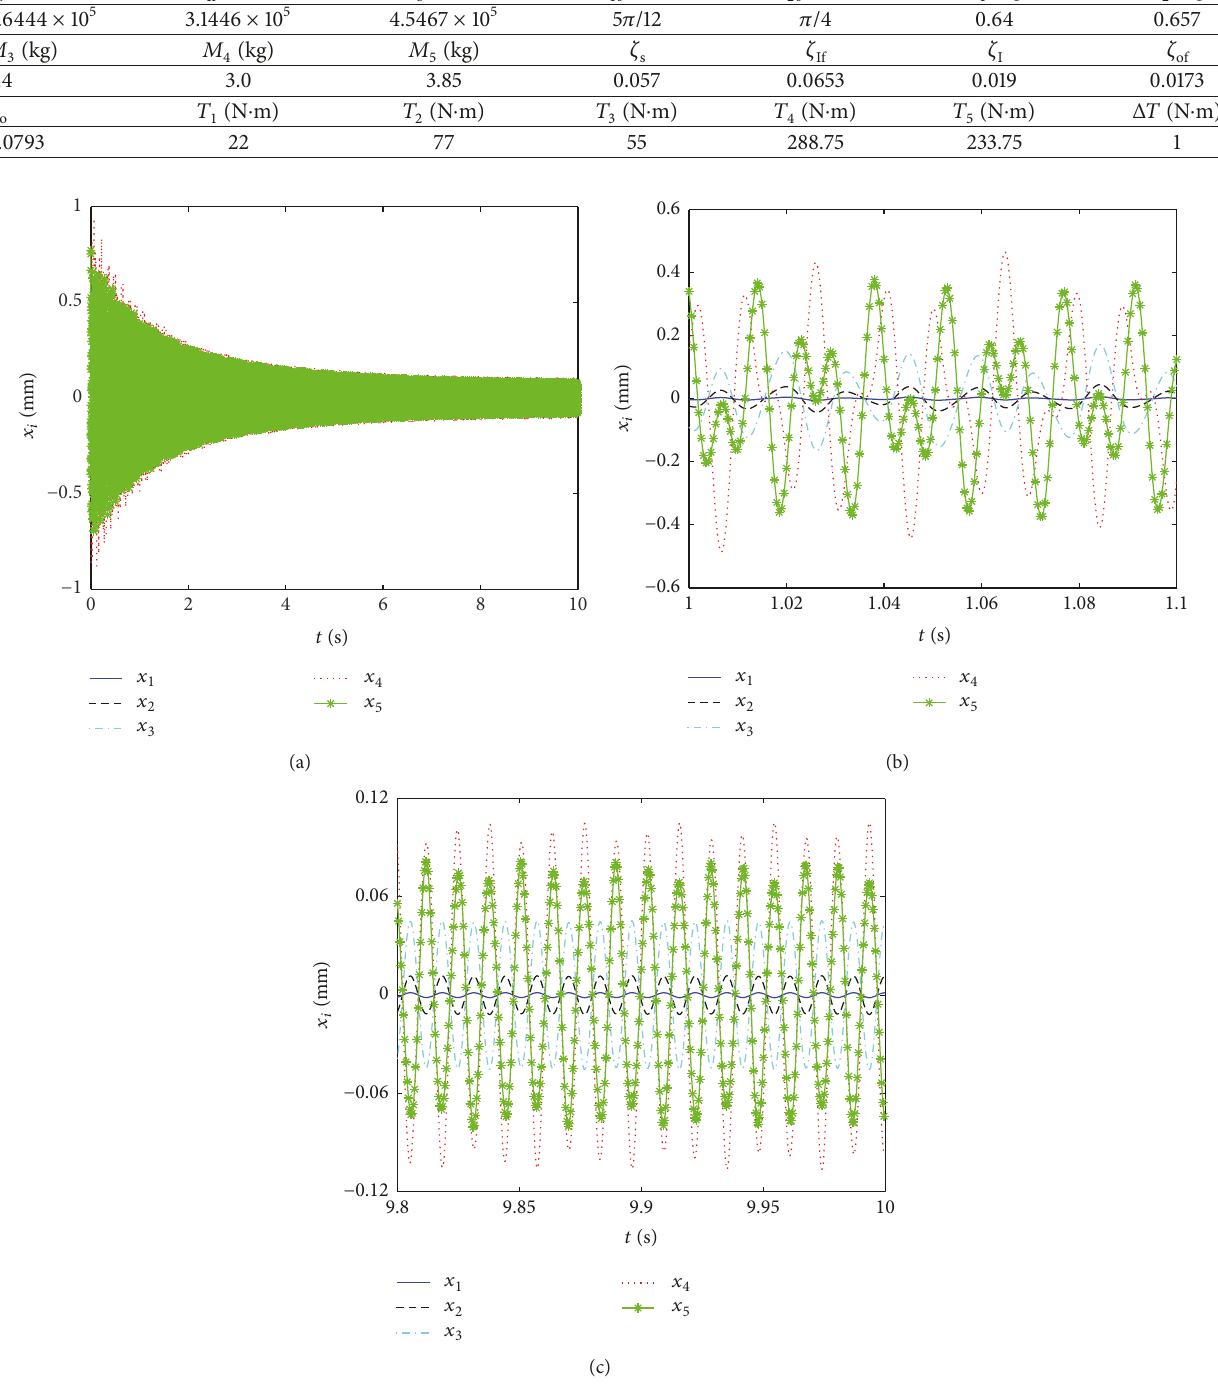
Figure 5: Transient responses of EIMG system when 𝜔 𝑒 ≈ 𝜔 4